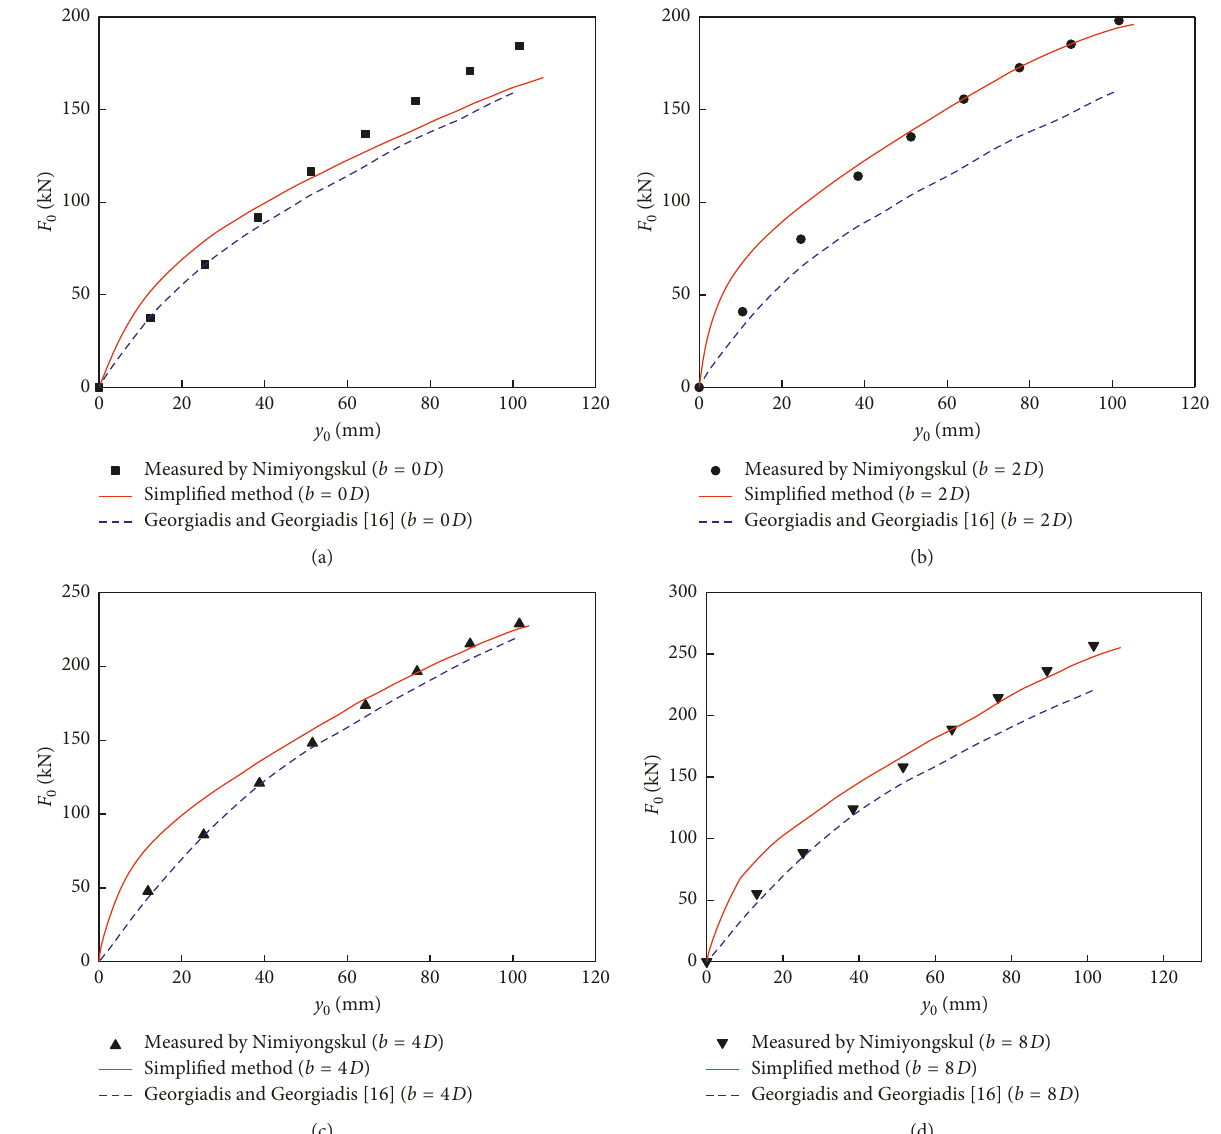
Figure 5: Comparison of lateral load ( F (d) b � 8 D